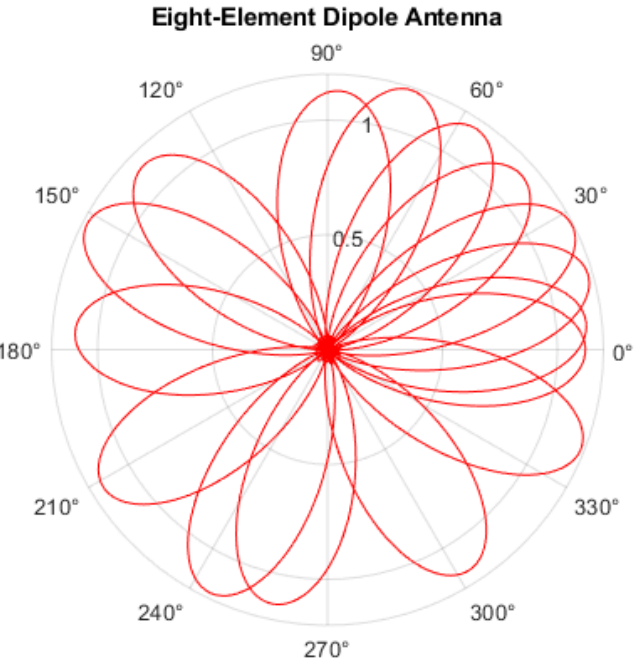
Figure 6. Radiation pattern for arbitrarily steering beams.